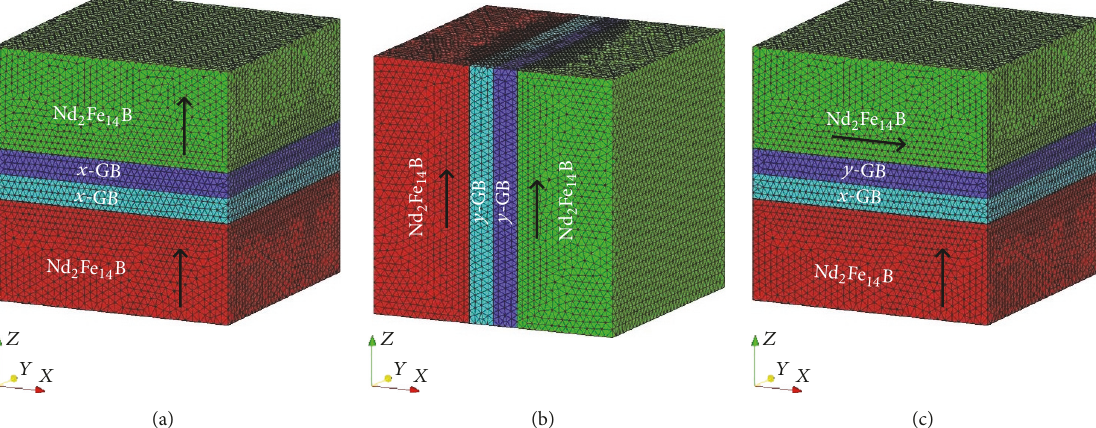
Figure 3: Micromagnetic finite element model structure with two Nd 2 Fe 14 B grains separated by a 2-phase GB, (a) “aligned” magnet with GB ⊥ to [001] : 𝑥 -GB, (b) “aligned” magnet with GB ‖ to [001] : 𝑦 -GB, and (c) “random” magnet with mixed GB-phase: 𝑥 -GB ⊥ to [001] and 𝑦 -GB ‖ to [001]